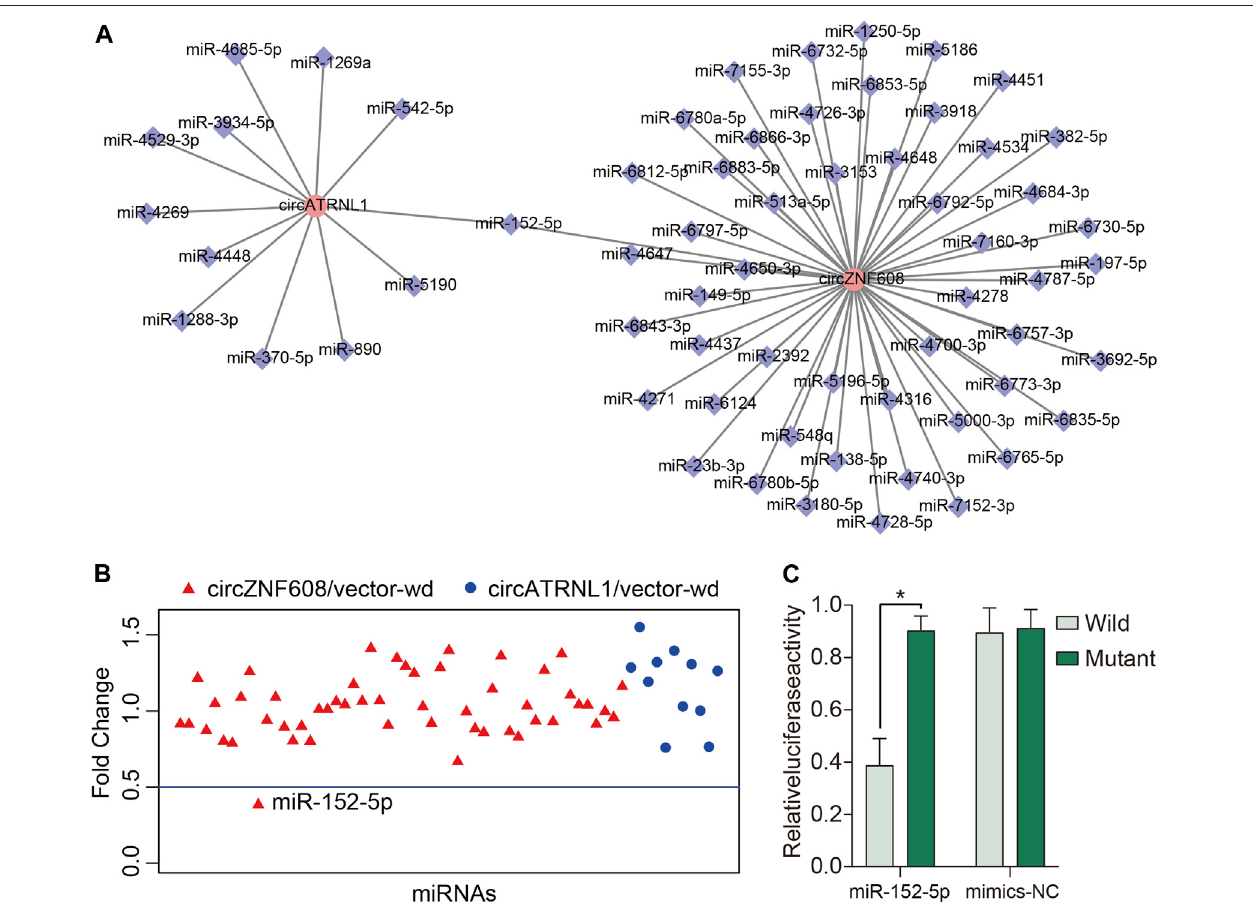
FIGURE 3 | circZNF608 serves as a sponge for miR-152-5p in ovarian cancer cells. (A) The 63 predicted miRNA – circRNA interactions for circZNF608 and circATRNL1. (B) Luciferasereporterassayofthe63miRNA – circRNAinteractionstoidentifymiRNAsthatwereabletobindtothecircZNF608orcircATRNL1 sequence. Only miR-152-5p inhibited luciferase activity by more than 50%. (C) Luciferase reporter assay for the luciferase activity of wild-type and mutant circATRNL1 vectors cotransfected with miR-152-5p mimics or mimic-NC (negative control of